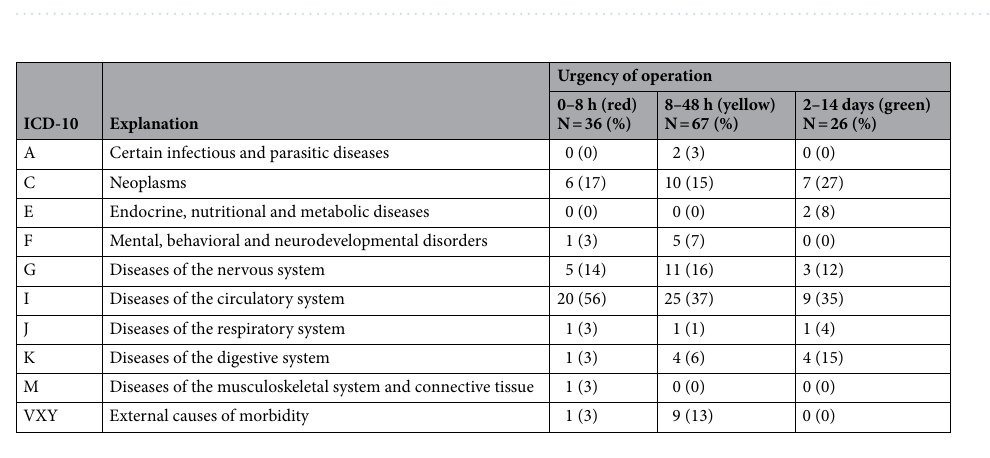
Figure 2. Cumulative mortality. Urgency of emergency operation: red = 0–8; yellow = 8–48 h; green = 2–14 days.